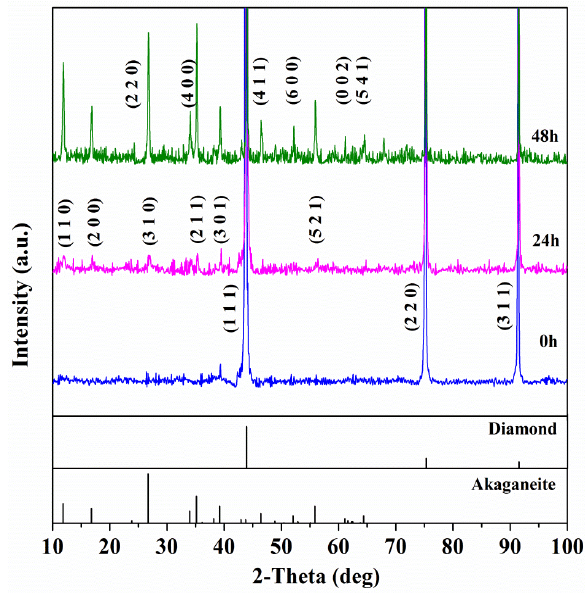
Figure 1. XRD patterns of diamond/akageneite hybrid particle with different reaction durations.